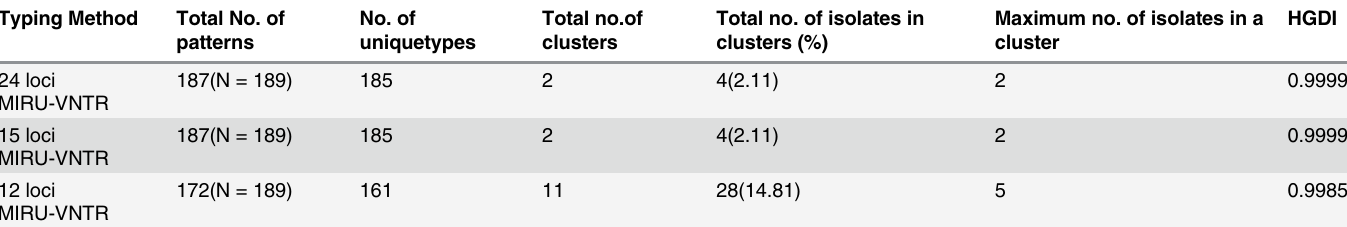
Table 3. Hunter Gaston Discriminatory Index (HGDI) and cluster results based on MIRU-VNTR loci analysis of 189 Mycobacterium tuberculosis complex (MTBC) isolates from Assam. Typing Method